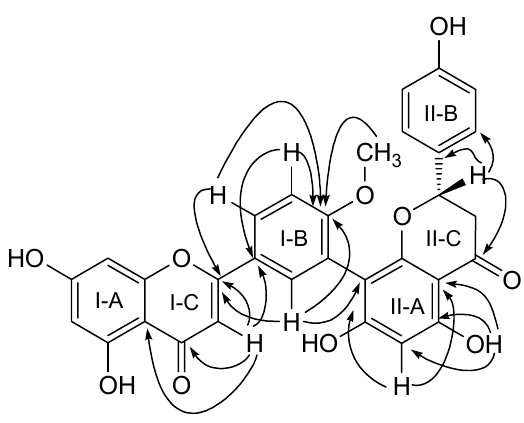
Figure 2. Key HMBC of compounds 1